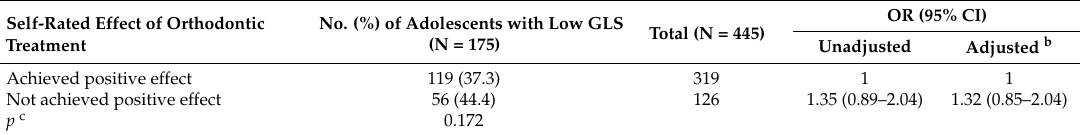
Table 4. Prevalence of low global life satisfaction in a group of adolescents with malocclusion (dentist confirmed) who had completed orthodontic treatment, by self-reported effect of treatment a . OR (95% CI) No. (%) of Adolescents with Low GLS Self-Rated Effect of Orthodontic Total (N = 445) (N = 175) Treatment Unadjusted Adjusted b Achieved positive effect 119